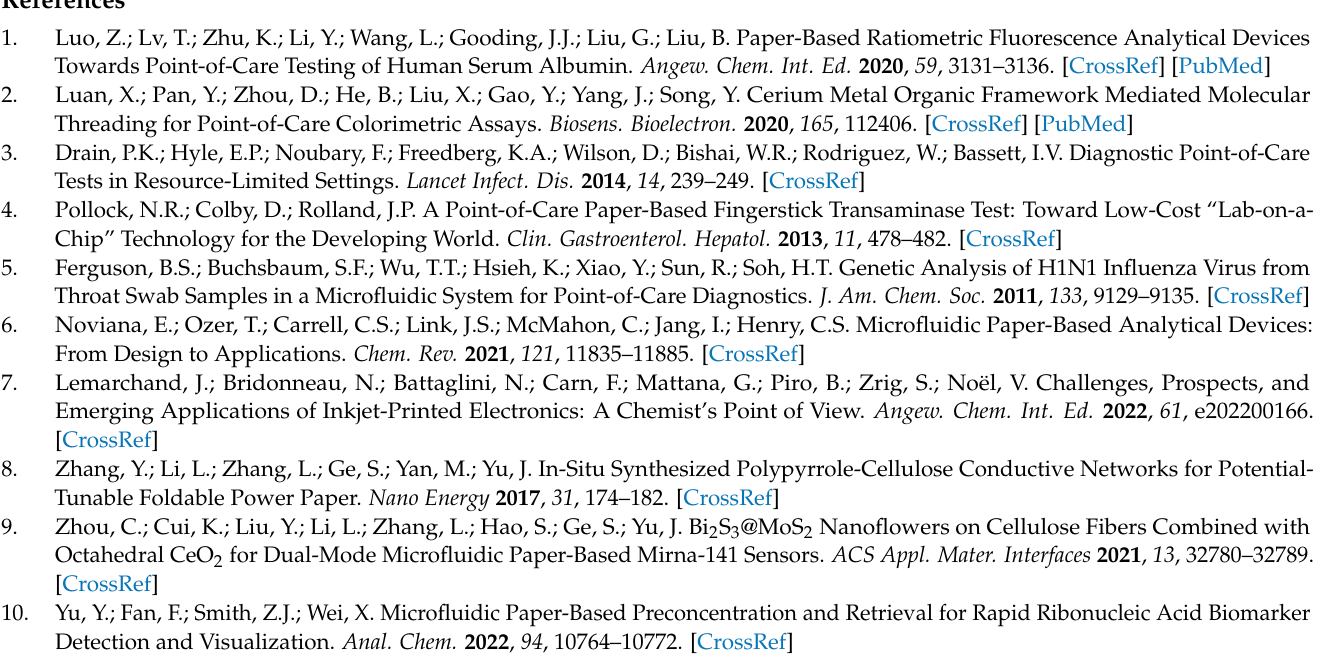
µ PAD. Figure S4: EDS spectrum of ZnO/ZnIn 2 S 4 . Figure S5: XPS spectra of ZnO/ZnIn 2 S 4 wide scan. Figure S6: Photocurrent of ZnO, ZnIn 2 S 4 , and ZnO/ZnIn 2 S 4 . Figure S7: Stability of the